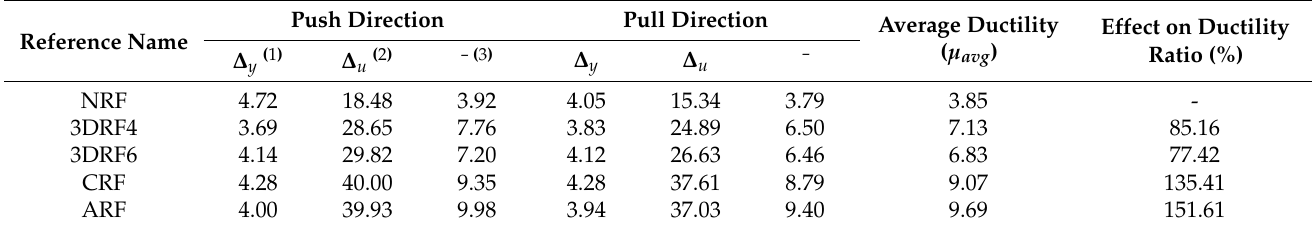
Table 5. Ductility ratio.